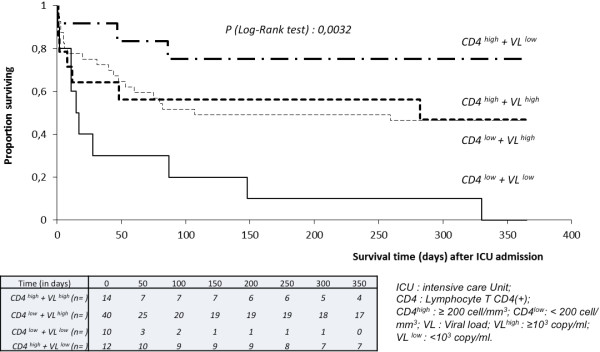
Kaplan-Meier survival curves illustrating time to death during the first year after admission in ICU according to the immune-virological status.